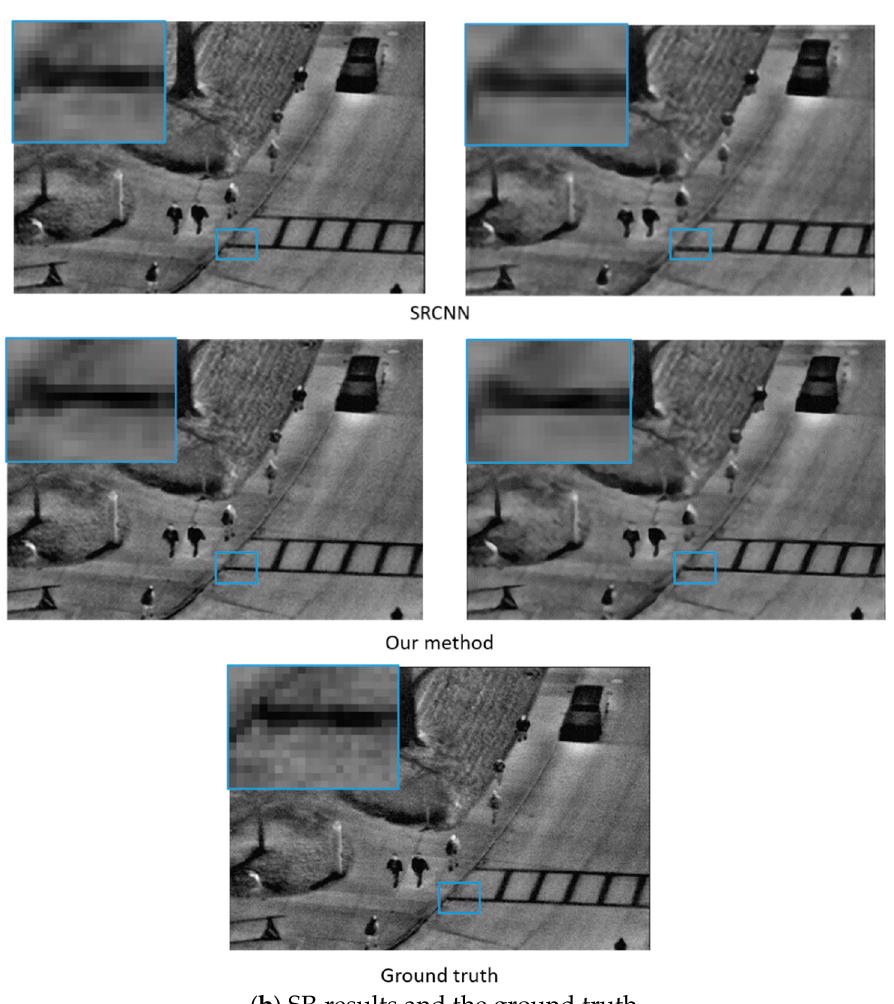
Figure 7. Visual comparison of SRCNN, ScSR and the proposed method with upscaling factors of 2 and 3.